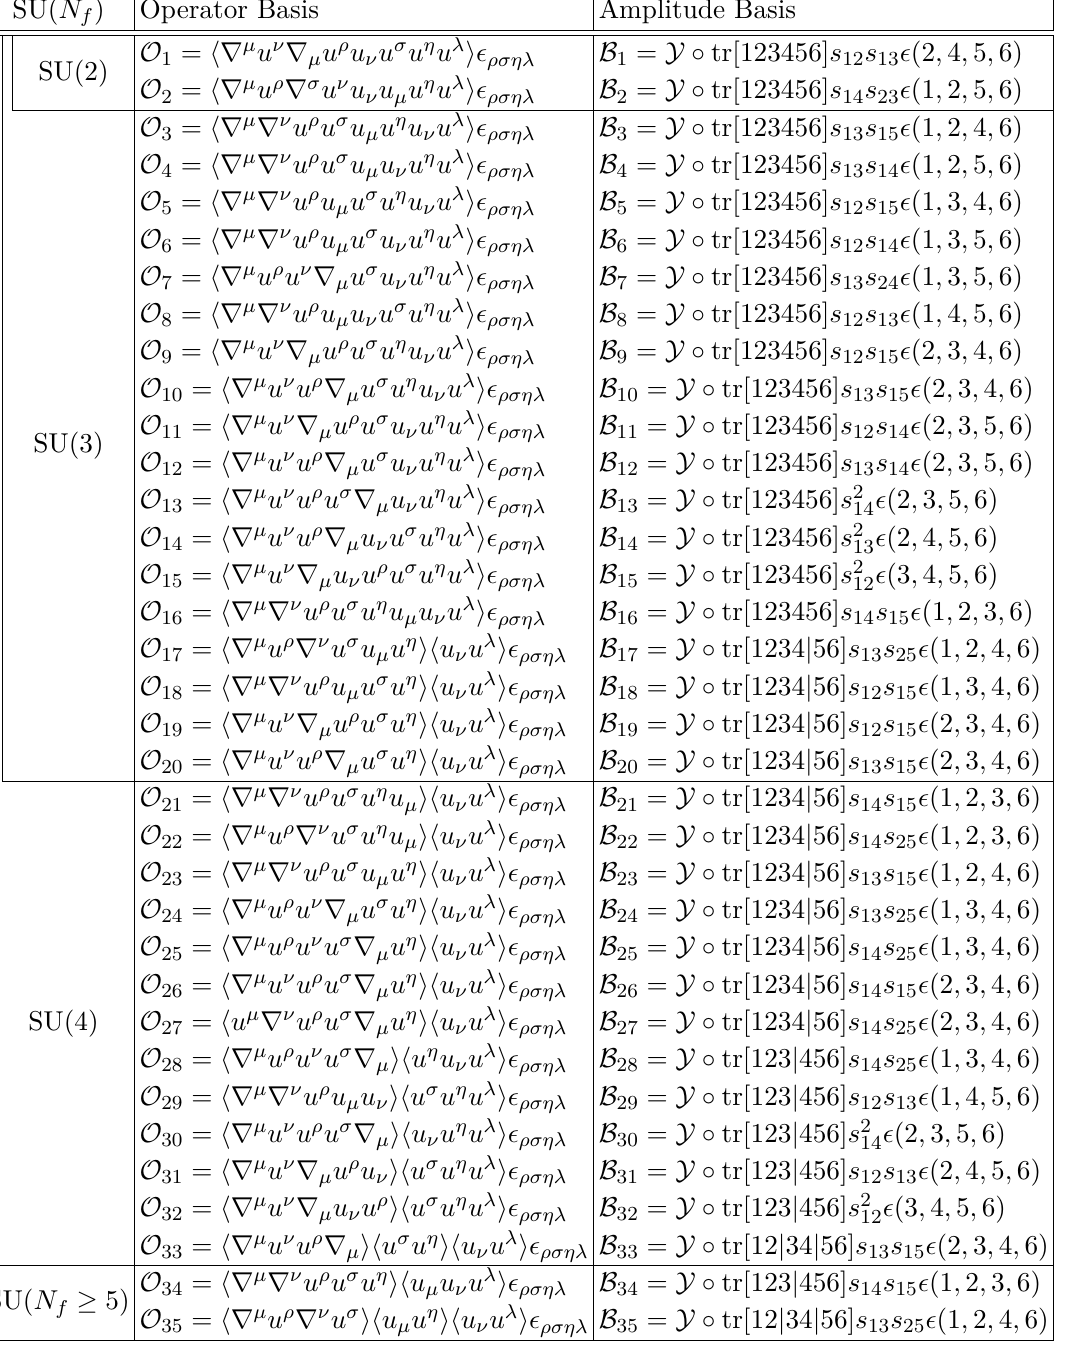
5) flavour groups are 2 , 20 , 33 and 35 f ≥